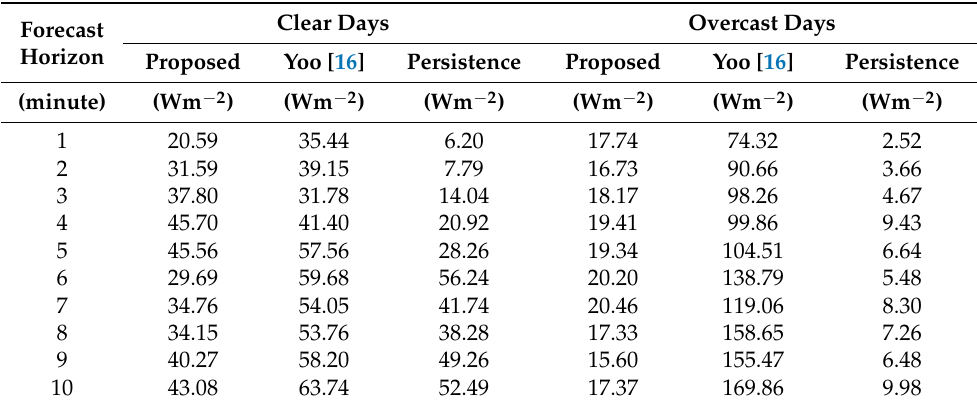
Table 4. Root mean square difference (RMSD) between the proposed, the Yoo, and the persistence models for clear days and overcast days.